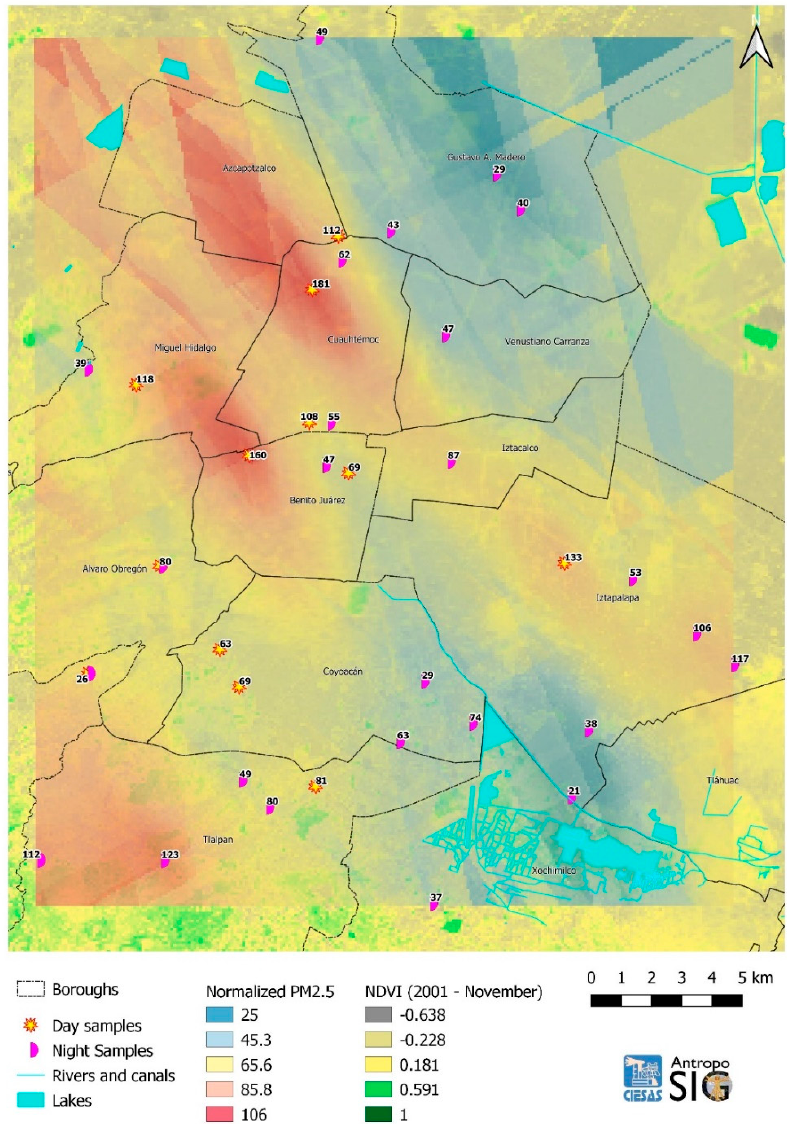
Figure 3. Spatial distribution of PM 2.5 in Mexico City.